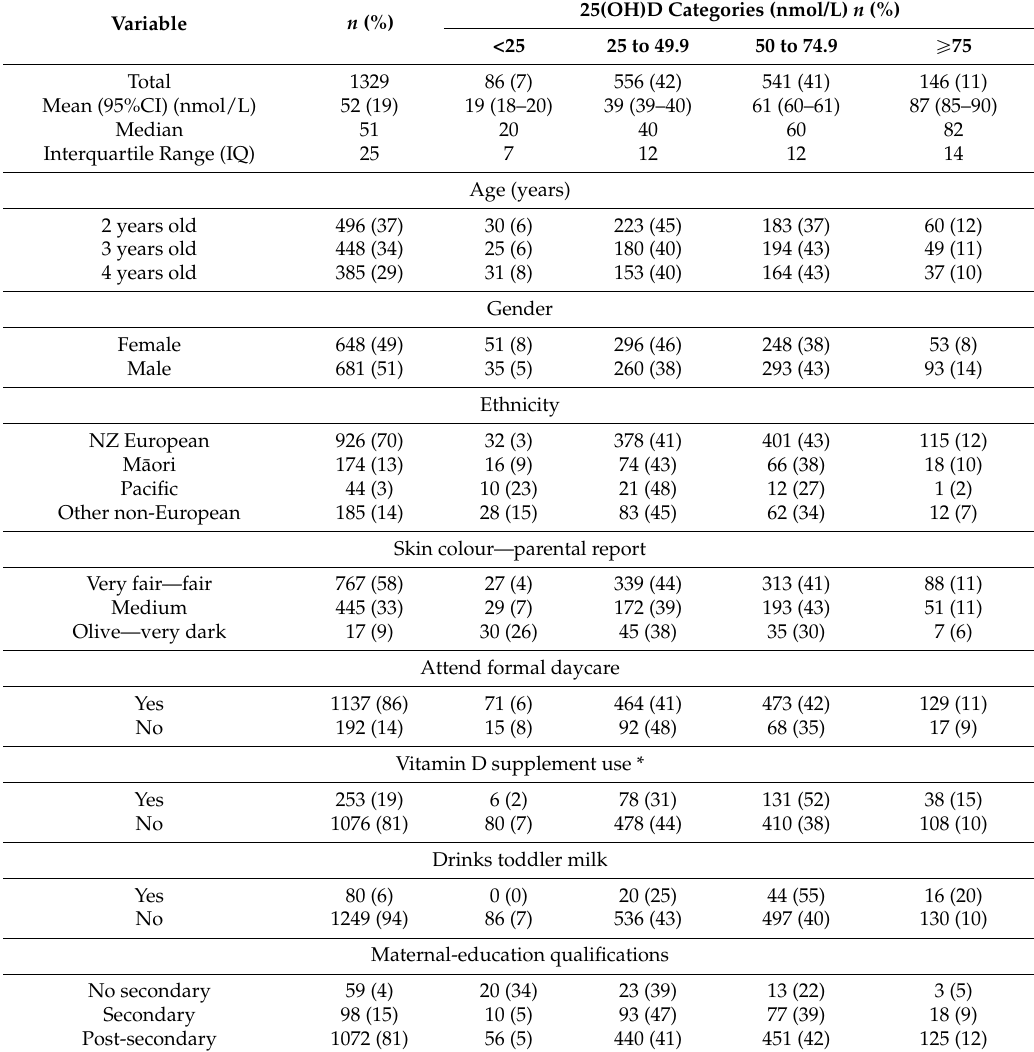
Table 1. Participant characteristics by dried blood spot 25(OH)D